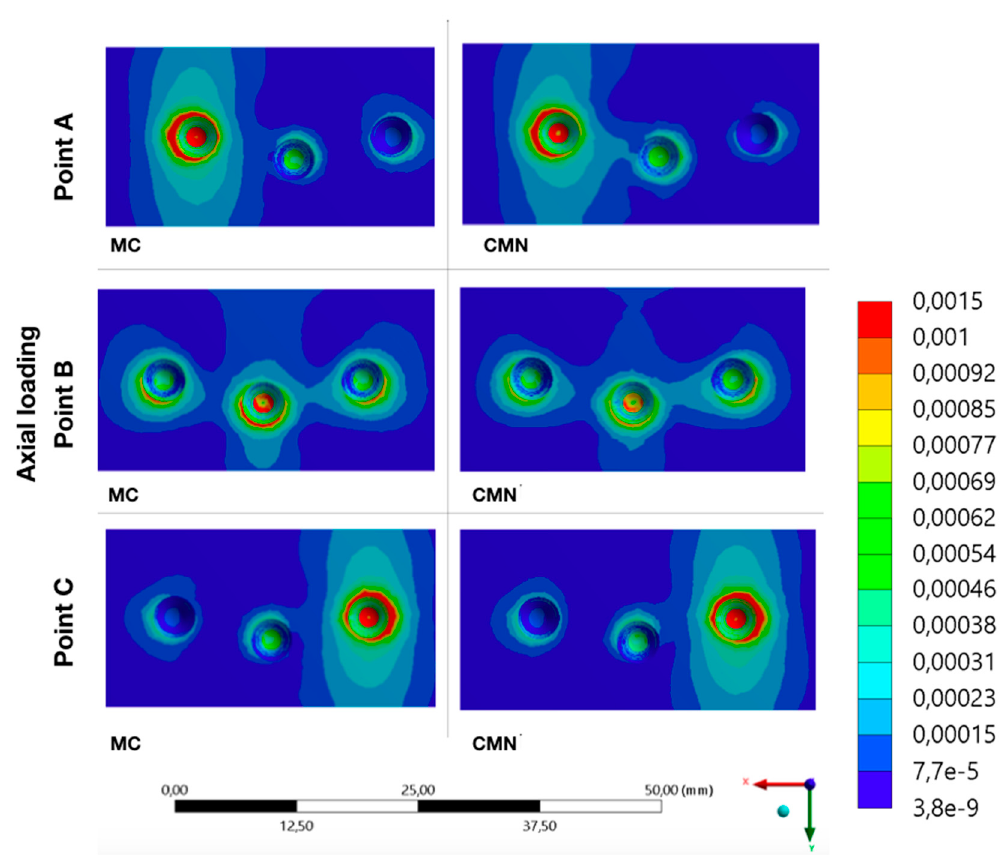
Figure 11. Microstrains ( µε ) at the substrate for the load application at points A, B, and C (CMN and MC groups).